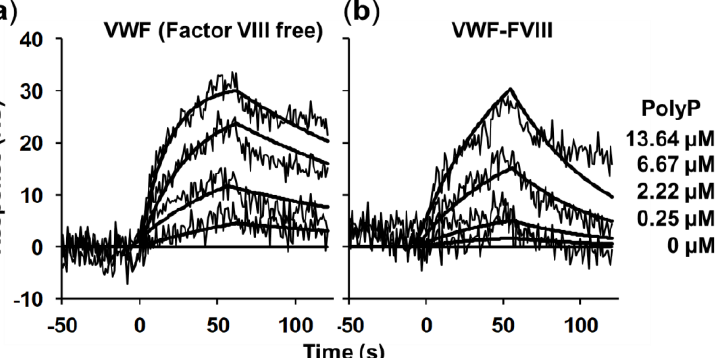
Figure 1. Dynamic interaction between von Willebrand Factor and polyphosphate is stronger in the absence of factor VIII. Surface plasmon resonance analysis of immobilized von Willebrand Factor (factor VIII-free) (VWF) ( a ) or von Willebrand factor co-purified with factor VIII (VWFFVIII) ( b ), confronted with increasing concentrations of isolated polyphosphate (polyP 65 , 0.25–13.34 µ M). The corresponding fitted curves are presented as solid lines. A representative experiment is shown (n =